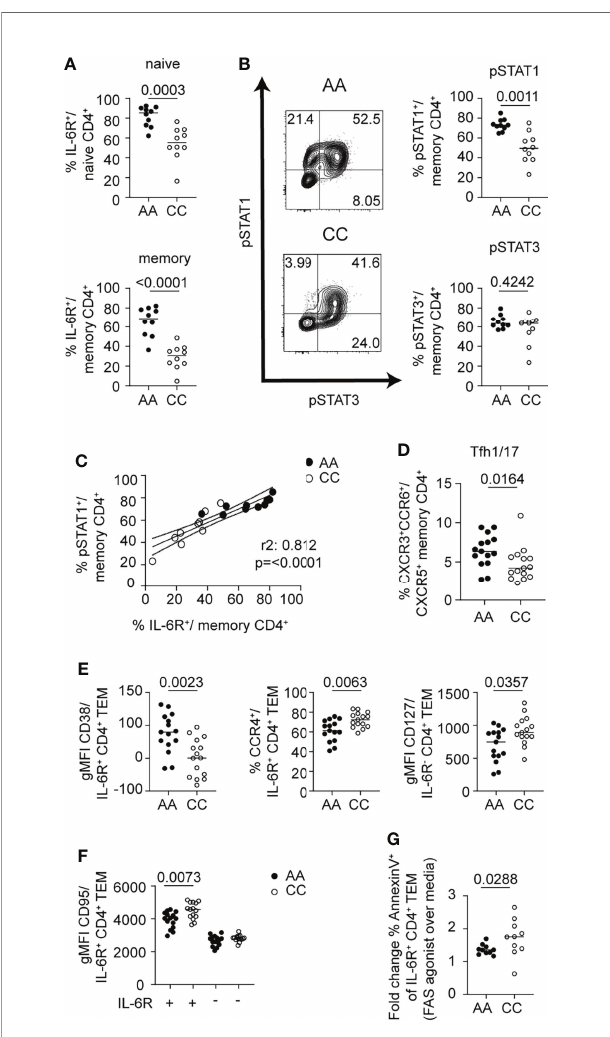
FIGURE 7 | mbIL-6R rs2228145 genotype determines pSTAT1 response to IL-6 and is linked to ex vivo phenotypic differences in CD4 + T cells. CD3- enriched T cells from carriers of the mbIL-6R hi /A or mbIL-6R lo /C allele were (A, C – F) left unstimulated or (B, C) stimulated with IL-6 (20 ng/mL) for 30 min and surface markers or the pSTAT1 and pSTAT3 response were determined by fl ow cytometry. (A) Frequency of gated mbIL-6R + cells at baseline in naïve (CD45RA + ) or memory (CD45RA - ) CD4 + (non-Treg) T cells. (B) Representative fl ow plots (left) and summary data (right) of the frequencies of pSTAT1 + (top) and pSTAT3 + (bottom) cells in memory (CD45RA - ) CD4 + (non-Treg) T cells. (C) Simple linear regression analysis of the frequencies of mbIL-6R + and pSTAT1 + memory CD4 + (non-Treg) T cells. (D) Frequency of Tfh1/17 cells among memory CD4 + (non-Treg) T cells or (E, F) gMFI expression levels of CD38, CCR4, CD127 and CD95/FAS in gated mbIL-6R + or mbIL-6R - TEM cells after 24 h in culture in the absence of stimulation. (G) CD3-enriched T cells were treated with agonistic FAS antibody or left untreated for 24 h and the change in the frequency of Annexin V + cells in gated CD4 + CD45RA - CD27 - CD62L - IL-6R + TEM cells was determined by fl ow cytometry. (A, B, D – G) Mann-Whitney test. (C) Linear regression analysis with Pearson ’ s correlation coef fi cients. (A – C, G) Pooled data from 2 independent experiments. Data from one experiment. (A) n = 20, ( B, C) n = 9-10, ( D – F) n = 15, (G) n =